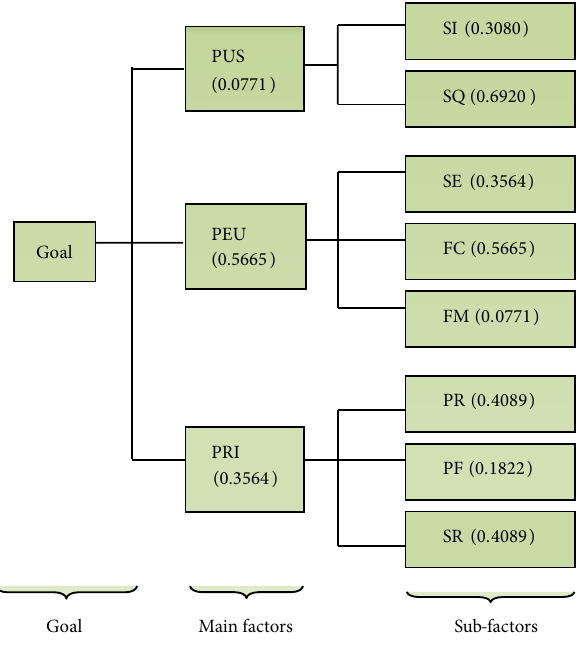
Fig. 3. Priority weights of main factors and